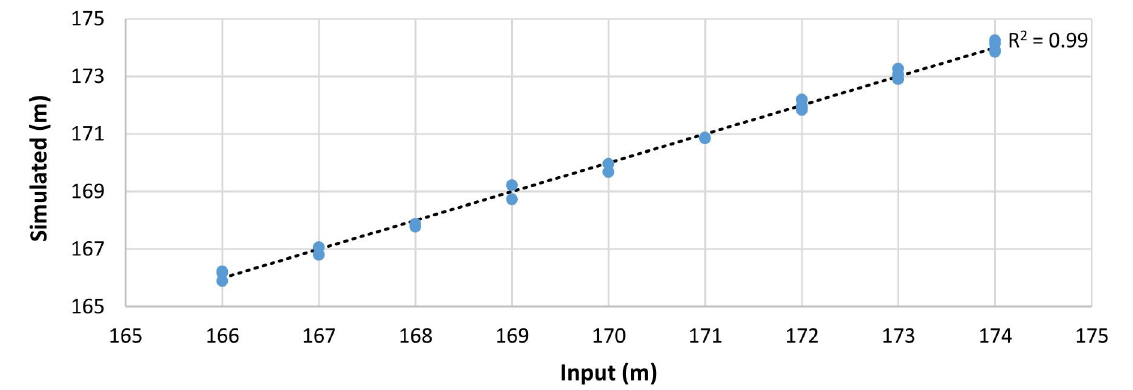
Figure 4. Relation of input groundwater heads at the boundary and simulated values of groundwater levels in control points.